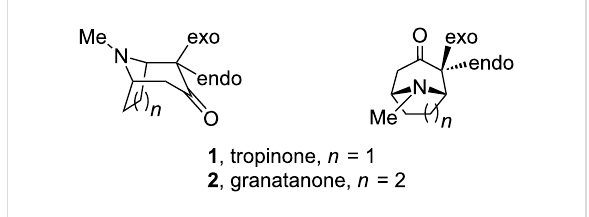
Figure 1: The exo and the endo substituents at the α -carbon (C-2 by tropane numbering) of the tropinone or granatanone scaffold shown in two alternative